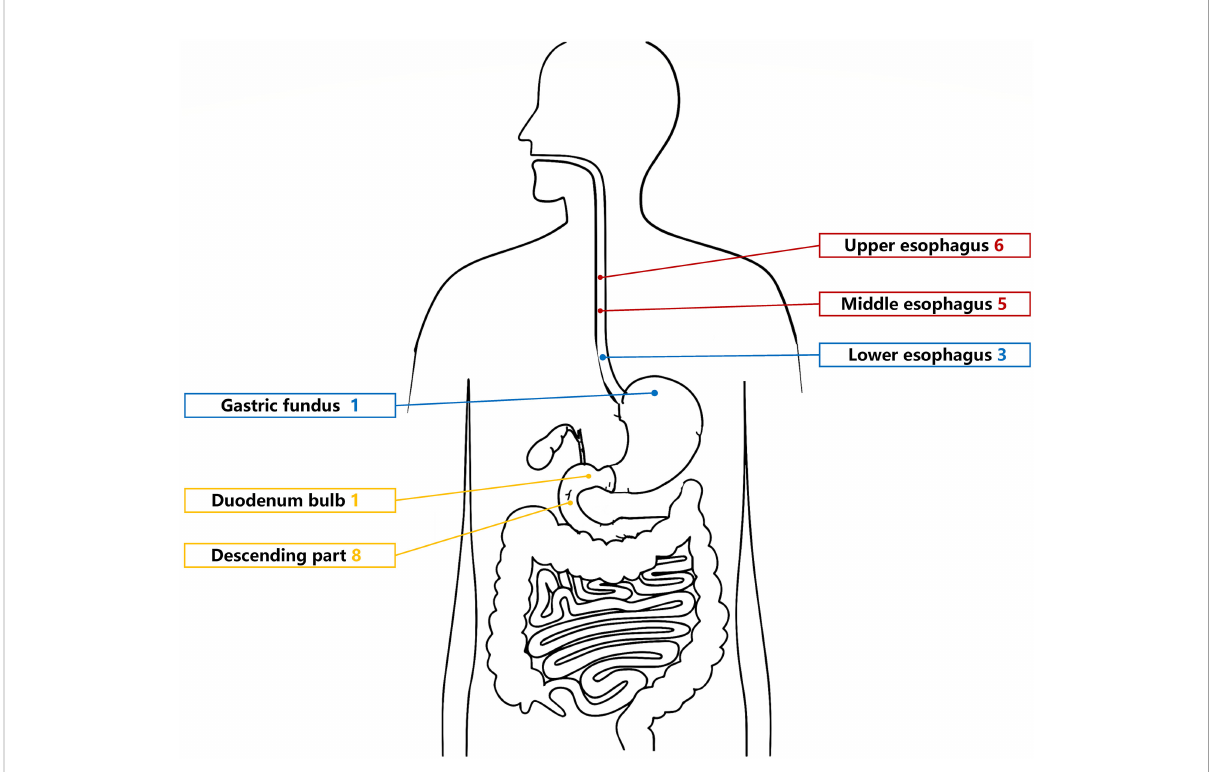
FIGURE 1 Site of lymphangiomas in the upper gastrointestinal tract.